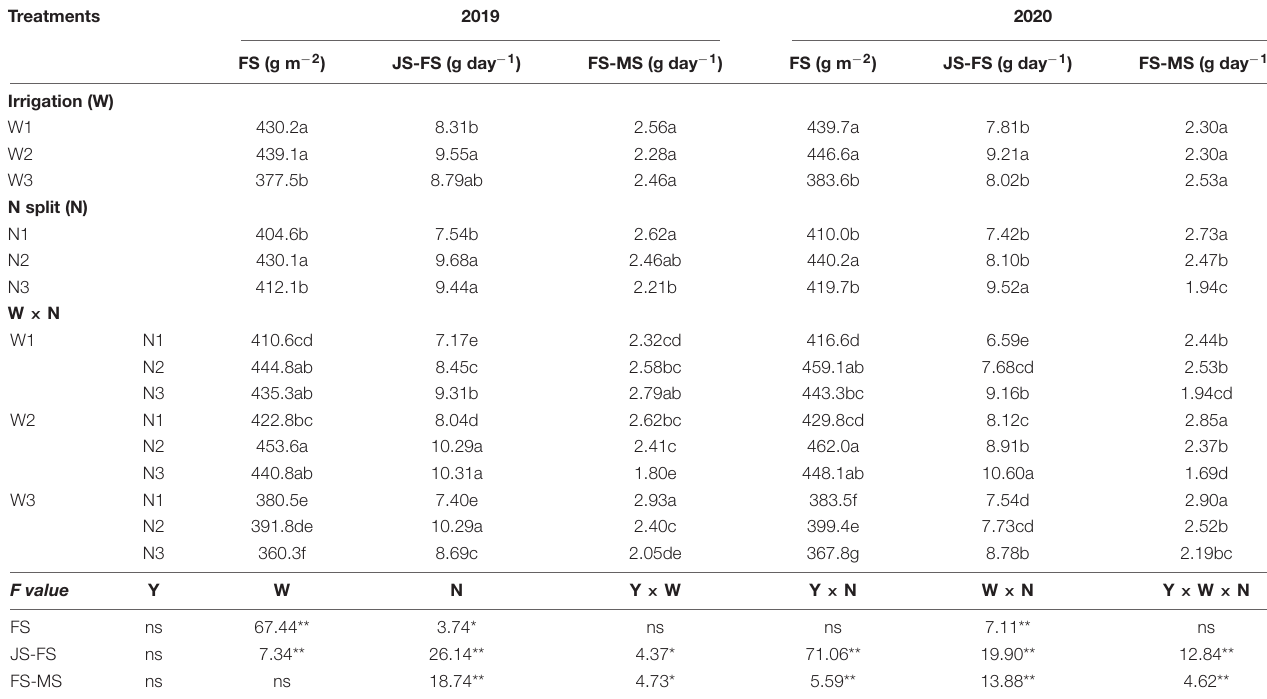
TABLE 1 | Effect of the irrigation methods and N split applications on root dry weight (RDW).